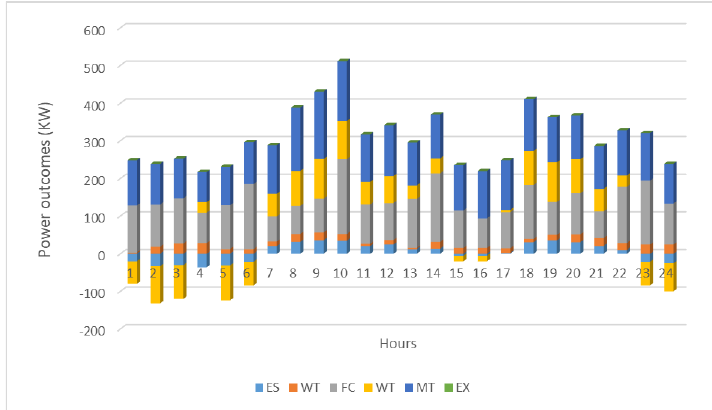
Figure 10. A microgrid ’ s typical daily recourse load outputs.